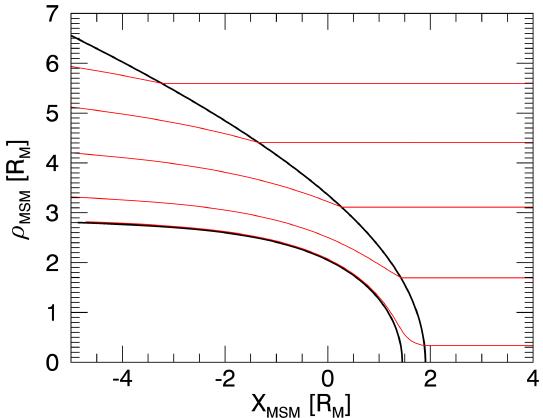
Figure 2. Schematic representation of the flow lines (red) in the MSM equatorial plane. The solid black lines are the bow shock and magnetopause evaluated from Eqs. (2) and (3),